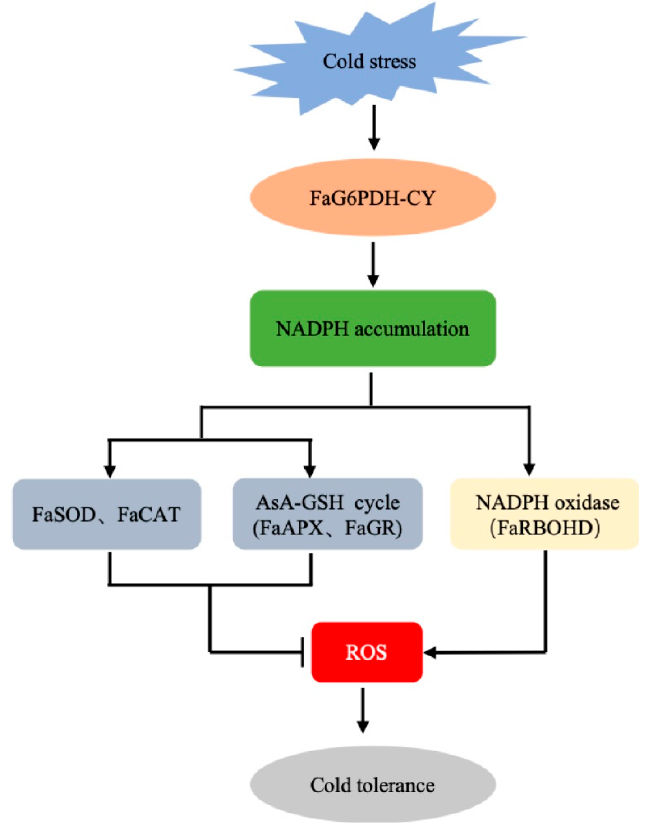
Figure 8. A putative model for FaG6PDH in response to cold stress in strawberry. When